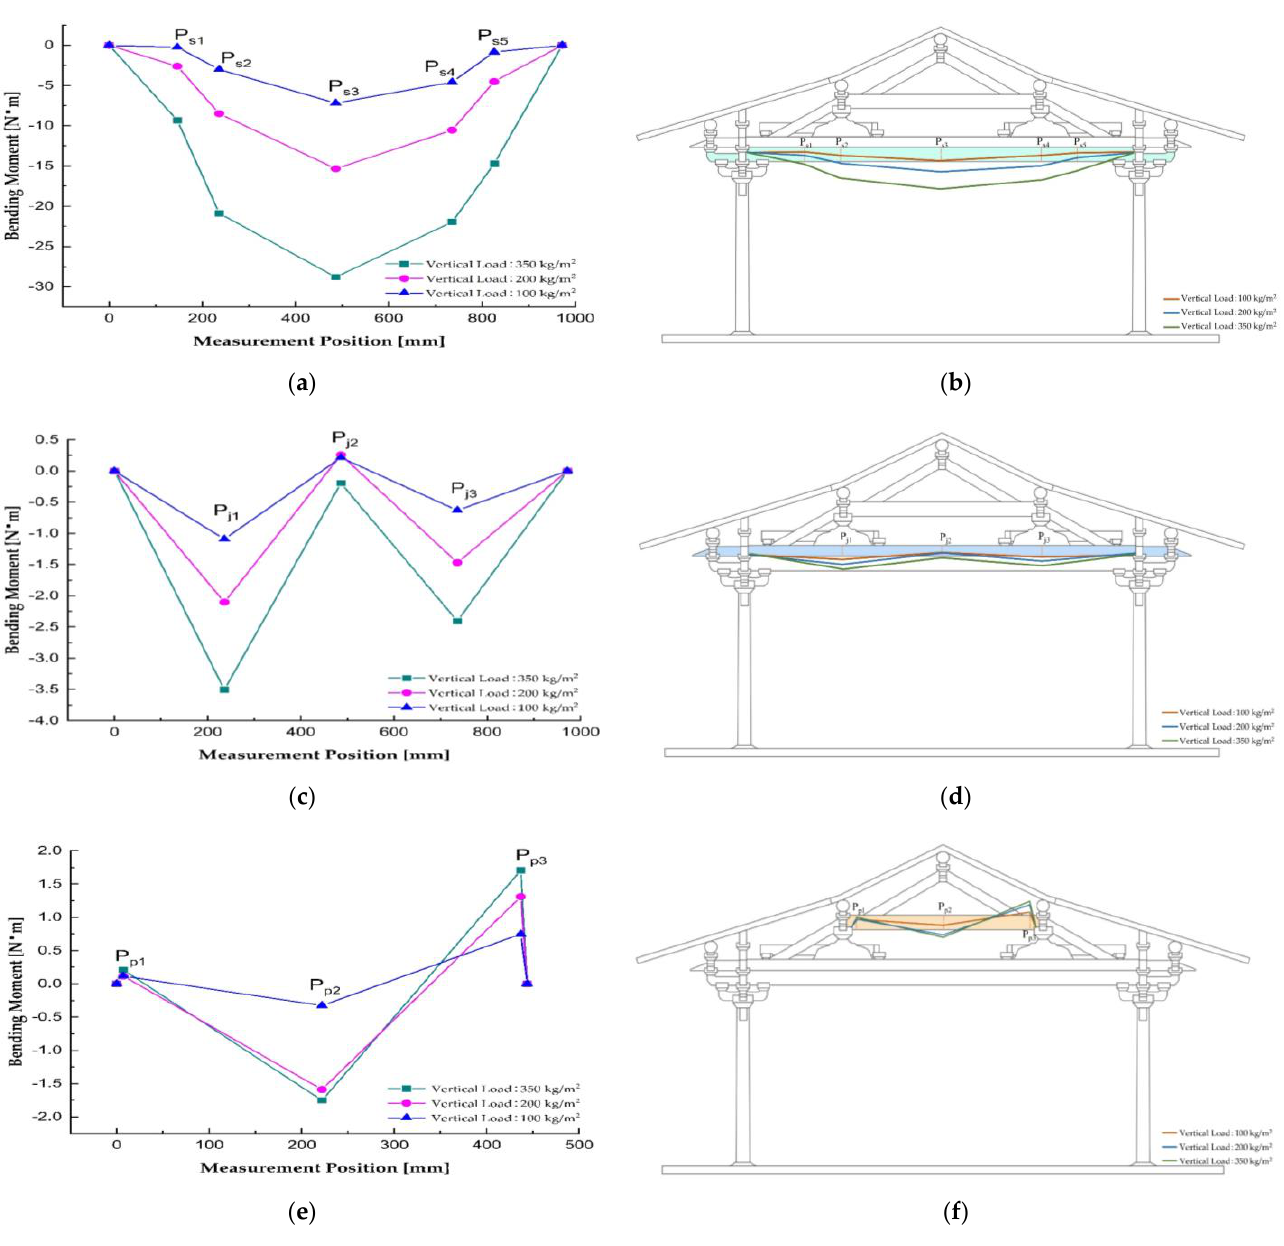
Figure 13. Bending moment and deflection location illustration of components. ( a,b ) Sichu Fu. ( c,d ) Jiao Bei. ( e,f ) Ping Liang (P s , P j and P p in the graph indicate the attached position of strain gauge). Lan’E, as a transverse component connecting the columns, produces very little bending deformation Figure 14a,b,d,e when the building is applied to a vertical load. The results show that the vertical load does not bend the appendage, and it does not act as a load- bearing element. However, as Figure 14b,d show, the bending moment of P r4 , P r5 is greater than that of P r3 , P r6 , and the corner columns are subjected to greater vertical loads than the other